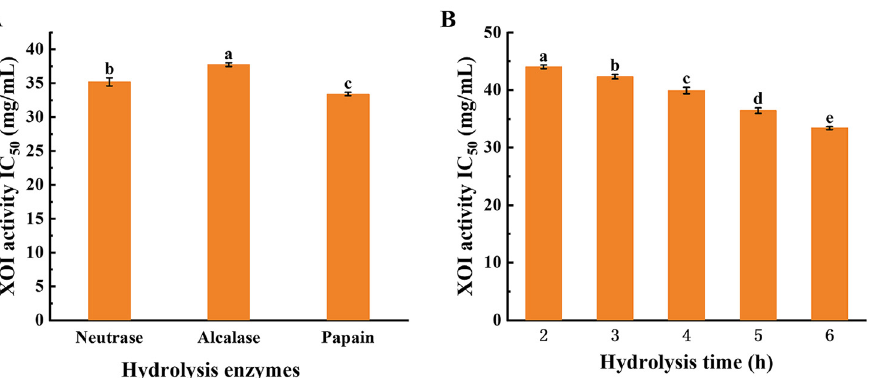
Figure 1. The inhibitory activity against xanthine oxidase with various hydrolysis enzymes and hydrolysis times of small yellow croaker hydrolysates (SYCHs). ( A ) Xanthine oxidase inhibitory (XOI) activity IC 50 of various hydrolysis enzymes in SYCHs for 6 h. ( B ) XOI activity IC 50 of papain SYCH. Data are shown as the mean ± standard deviation ( n = 3), and different letters (a–e) among samples indicate significant differences ( p <